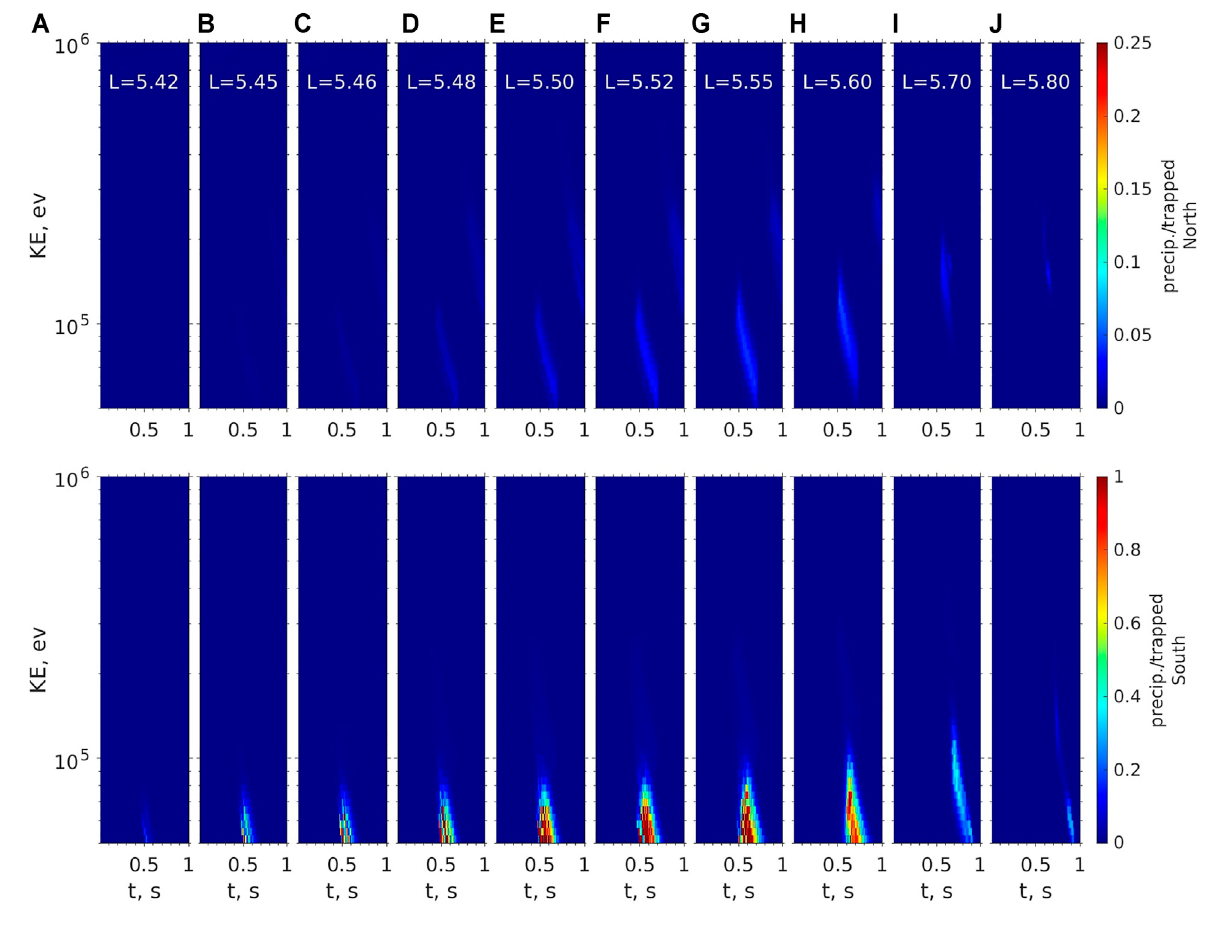
Frontiers in Astronomy and Space Sciences |